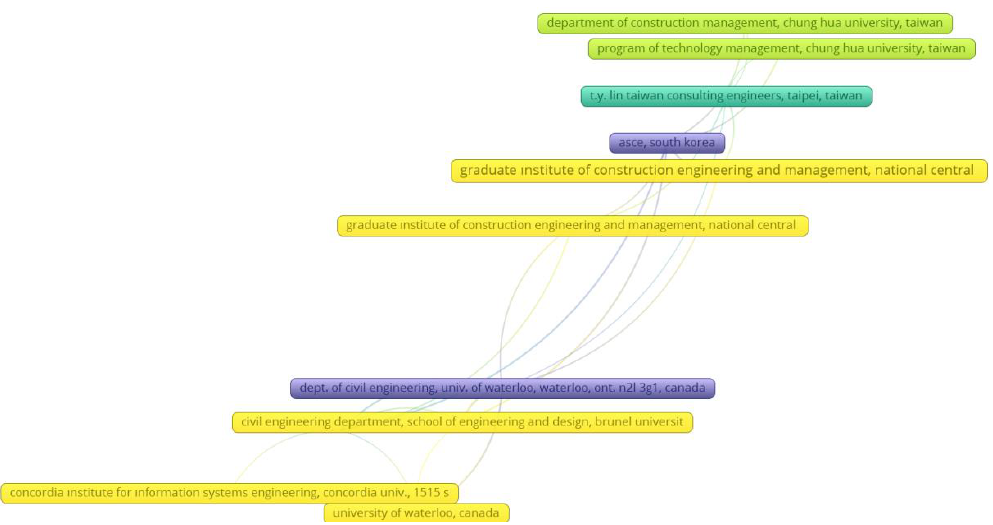
Figure 6. Mapping the organizations publishing documents related to delay analysis subject.